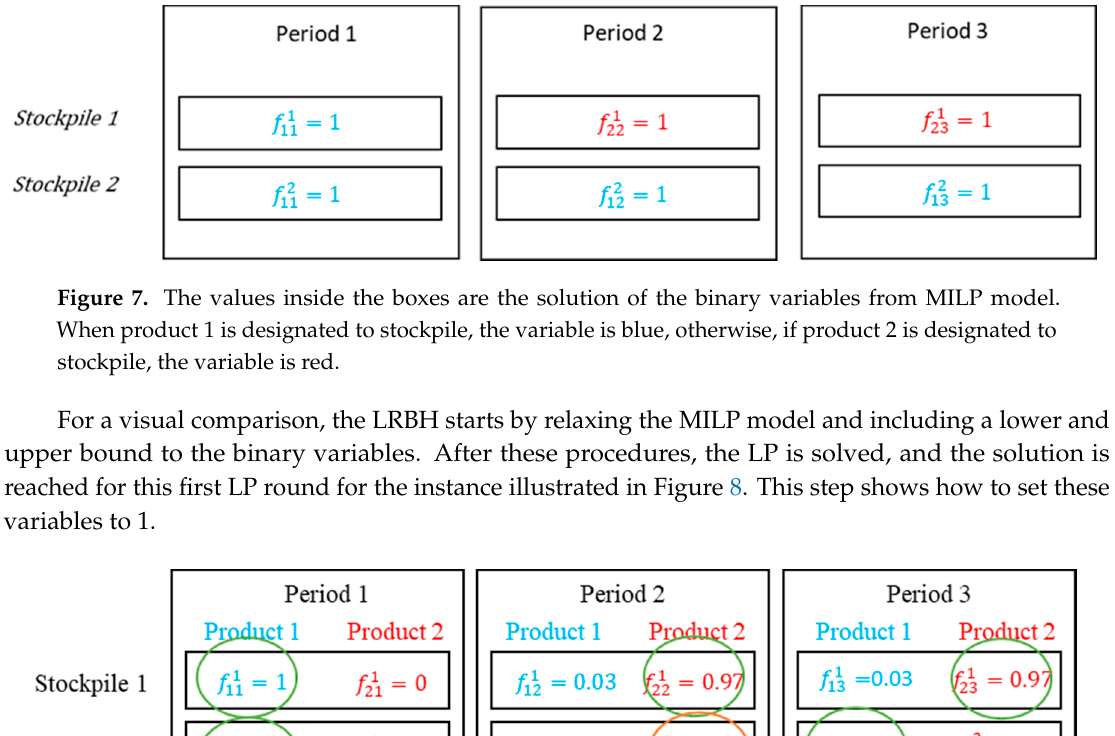
with the LP solution (See Table